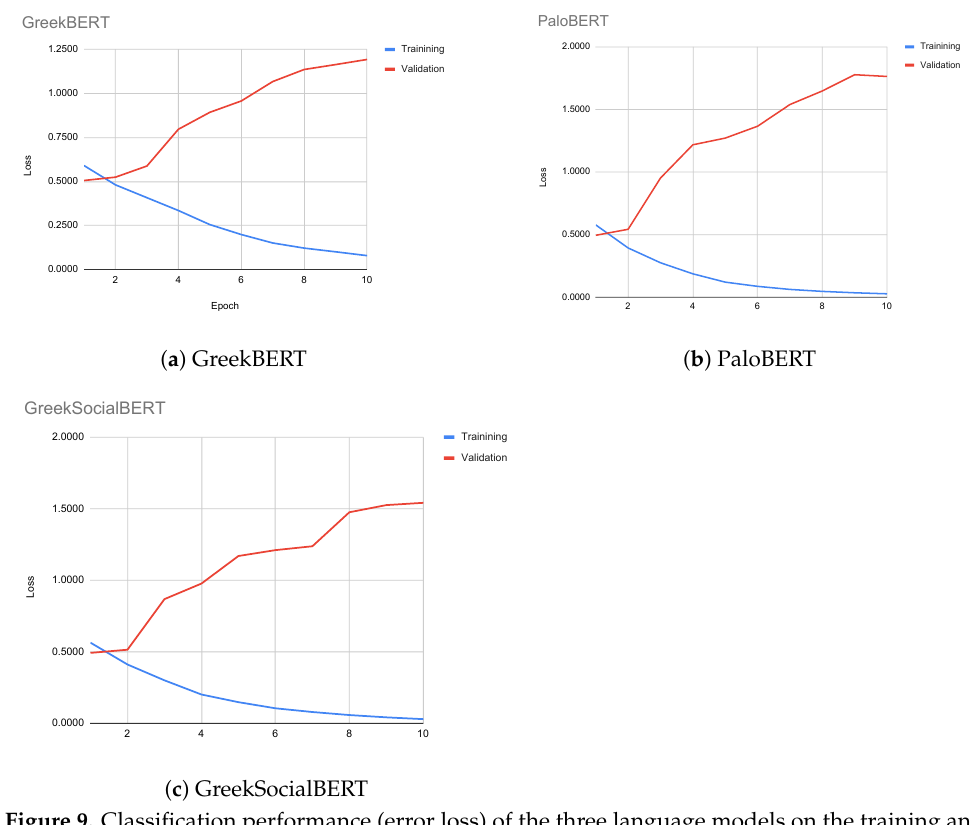
Figure 9. Classification performance (error loss) of the three language models on the training and validation datasets. Table 2. Classification performance using the different models ( P stands for precision , R for recall , F 1 for F 1 − score , and Avg . F 1 for the micro-averaged F1-score) in the three classes (i.e., Negative, Positive, Neutral). The first table assumes minimum pre-processing of the texts of the labeled corpus (i.e., using pre-processing strategy p 1). The second table assumes additional pre-processing (i.e., using pre-processing strategy p